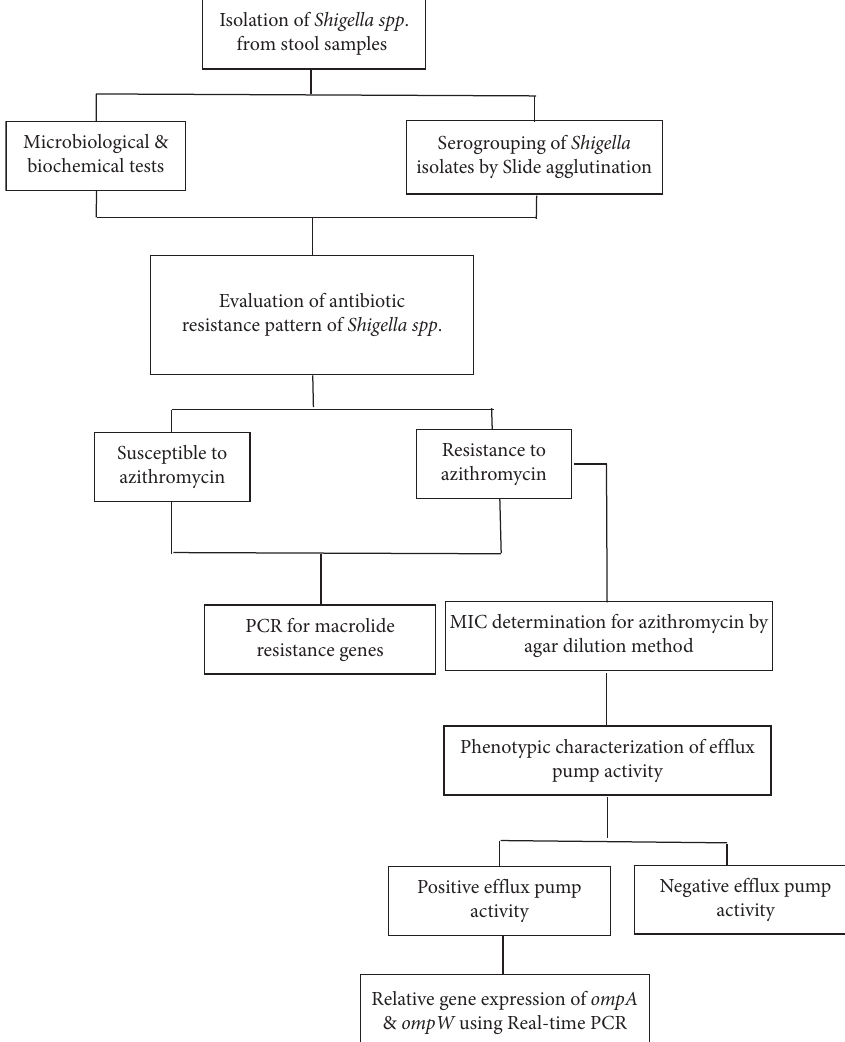
Figure 1: Work flowchart for identification Shigella isolates with decreased susceptibility to azithromycin (DSA) and characterization of the related genetic